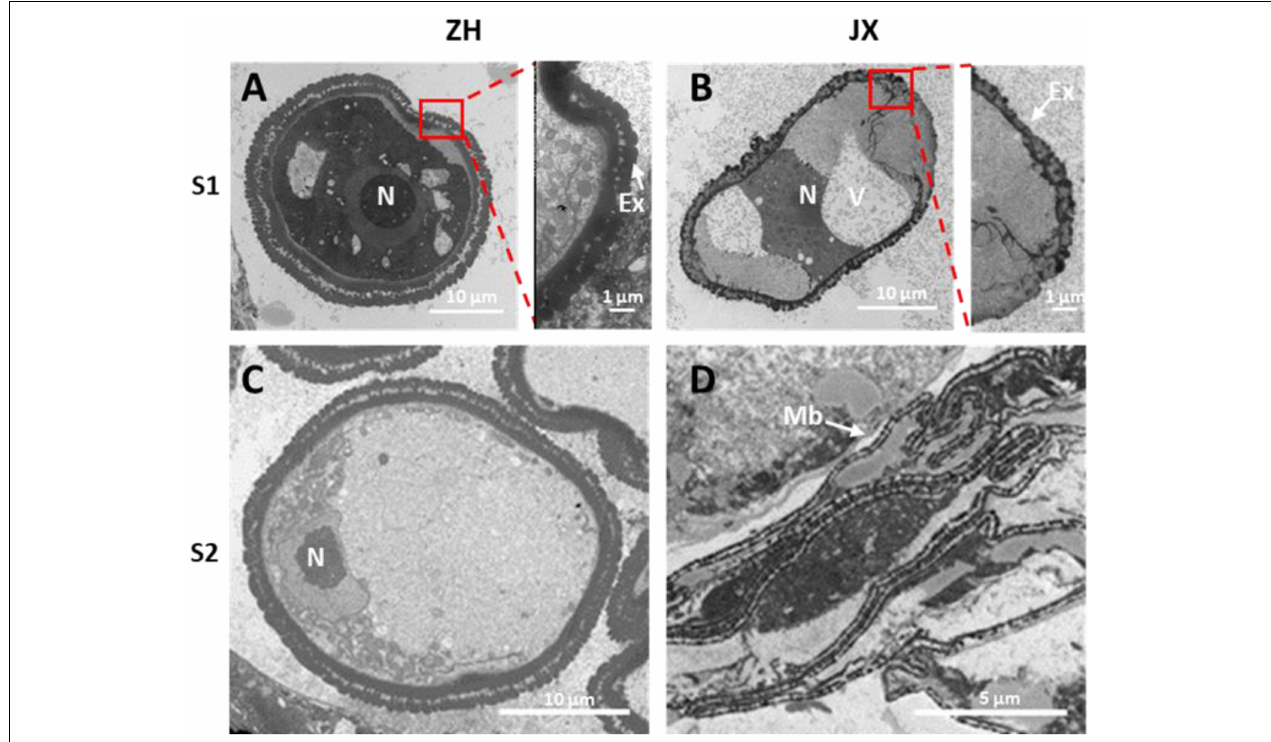
FIGURE 4 | Transmission electron microscopy (TEM) scans of microspore features at two stages in “JX” and “ZH.” N, nucleus; Ex, exine; V, vacuole; Mb, microspore bands. (A,C) represent microspores of ‘ZH’ at S1 and S2, respectively. (B,D) indicate microspores of ‘JX’ at S1 and S2, respectively.